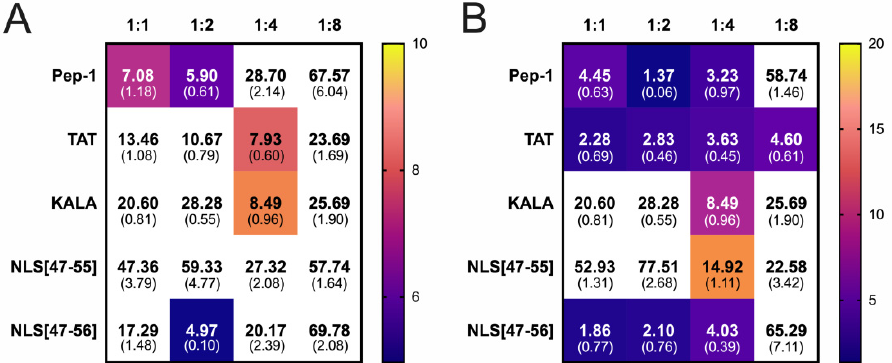
Figure 18. Results of 48 h culture in the presence of complexes in CRs of 1:1, 1:2, 1:4 and 1:8. The complexes were formed using incubation of 2 μ g pmaxGFP with chosen CPPs at 21 °C for 30 min. Bar = 50 μ m. CR, charge ratio.